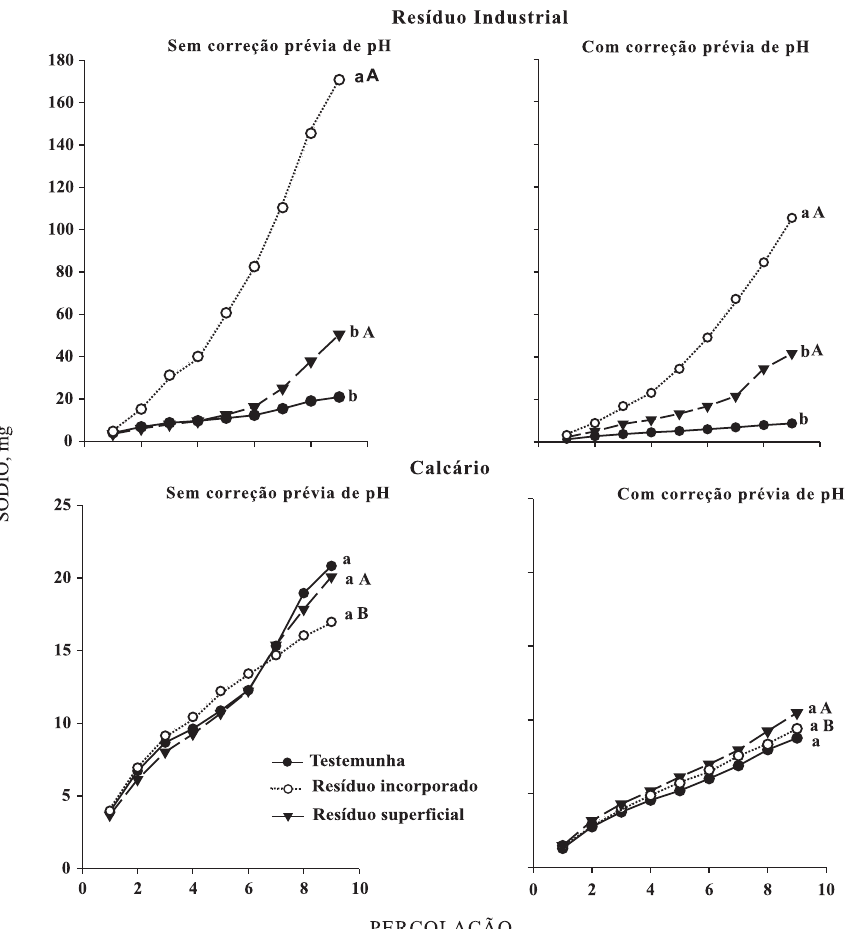
Figura 1. Perdas acumuladas de sódio após 10 percolações com água destilada em conseqüência da aplicação de calcário ou de um resíduo industrial em amostras de solo com e sem correção prévia de pH. (Letras minúsculas comparam as formas de aplicação de cada corretivo com a testemunha dentro de cada pH; letras maiúsculas comparam esses mesmos tratamentos entre os corretivos da acidez, dentro do